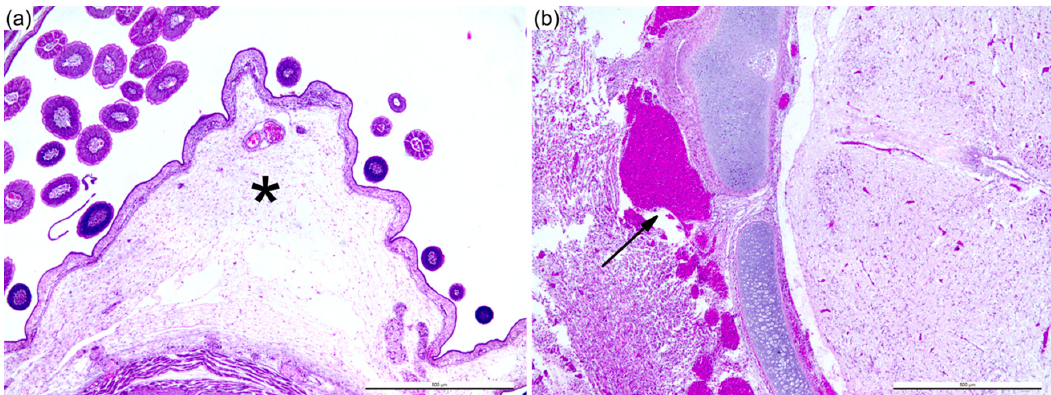
Figure 2. Pathology of Bluetongue virus (BTV)-infected chicken embryos at three days post infection (DPI). Expansion of subcutaneous space consistent with edema ( a ). Hemorrhage at the occipital region of the cranium ( b ). Scale bar = 500 μ m.